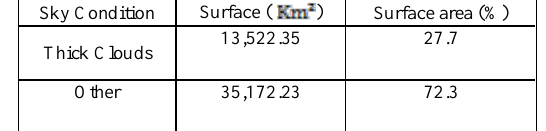
Table 5: Surface of thick clouds of the area concluded from threshold placing in the first group of models (April 20 th ) Sky Condition